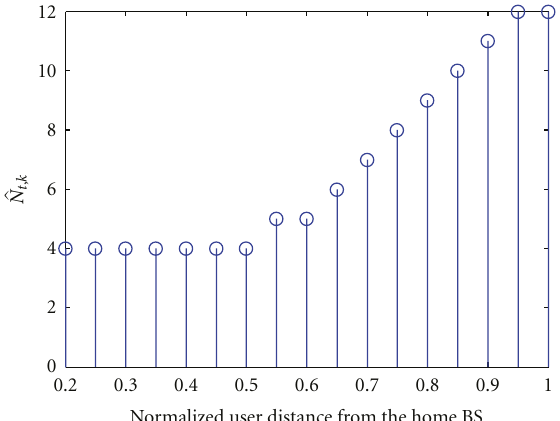
Figure 3: Equivalent number of transmit antenna (cid:7) N t , k versus the normalized distance from the home BS for a sample user k moving along the line that connects the BS 3 to the center of the shaded hexagon in Figure